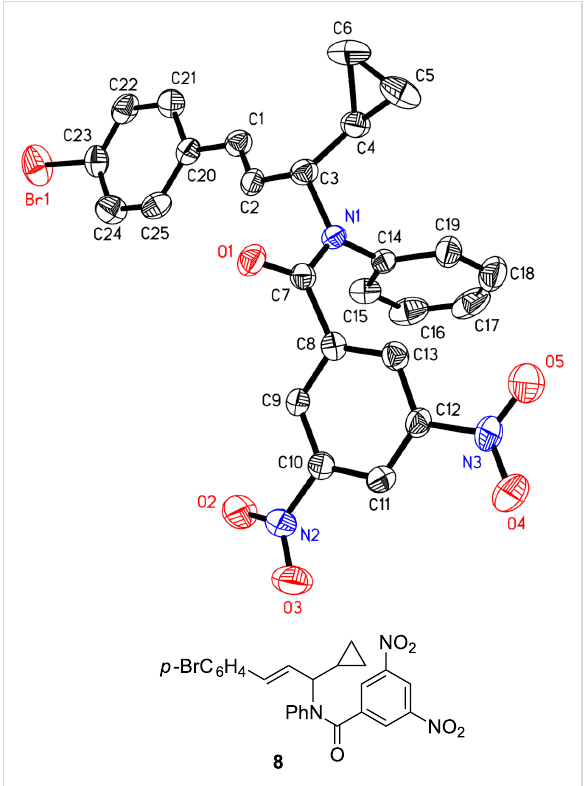
Figure 2: X-ray crystal structure of compound 8 .